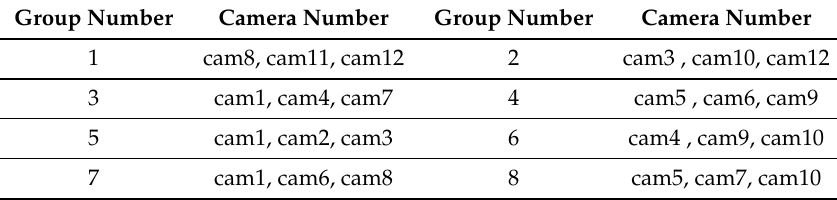
Table 1. Deterministic selection of different view